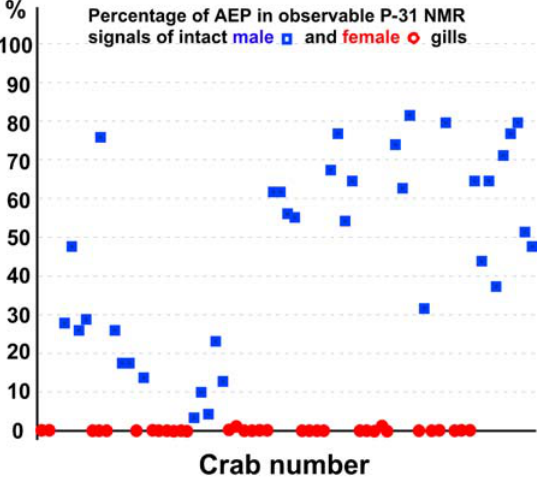
Figure 4. Percentage summary of AEP in male and female intact gills. A chronological presentation of results from the numerous groups of crabs covering six different years. It presents the P-31 NMR analyses of male and female intact gills with males represented by blue squares and females by red circles . The percentage of AEP for each blue crab was determined by dividing the integral of the AEP signal by the total integral from all observed P-31 signals from that crab. Only 2 of the 33 female crabs had any measurable AEP present. One of these female gills underwent a parallel fractionation with a male gill. See Figure 5.